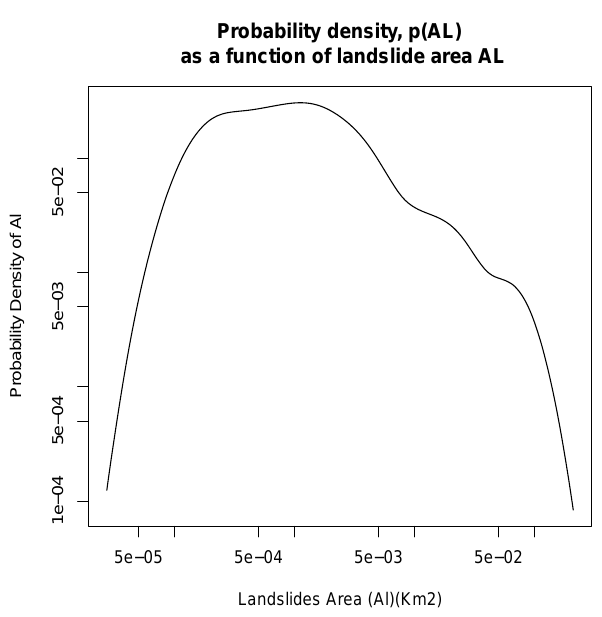
Figure 2. Probability density as a function of landslides area of the inventory map for